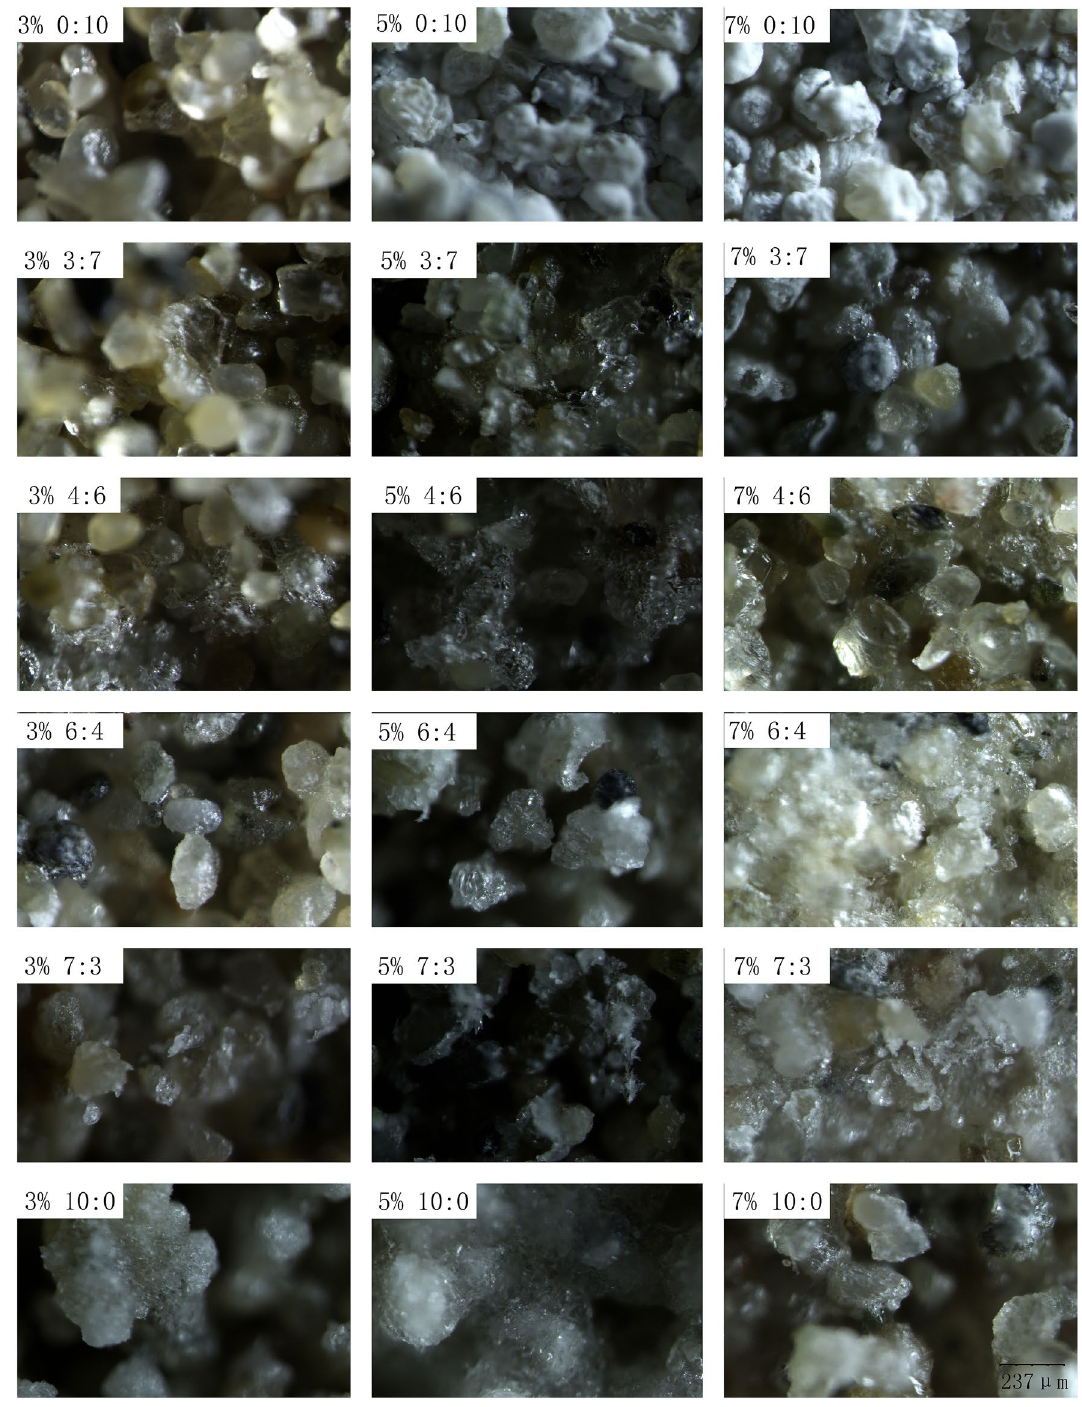
Figure 5. Microscopic images of soil salt crust. An SZ-12 stereomicroscope was used to obtain microscopic images. The percentages represent the mass percentage of salt, and the proportion represents the ratio of sodium sulfate to calcium chloride. For example, 3% 0:10 represents a salt content of 3% and salt mixture ratio (sodium sulfate:calcium chloride) of